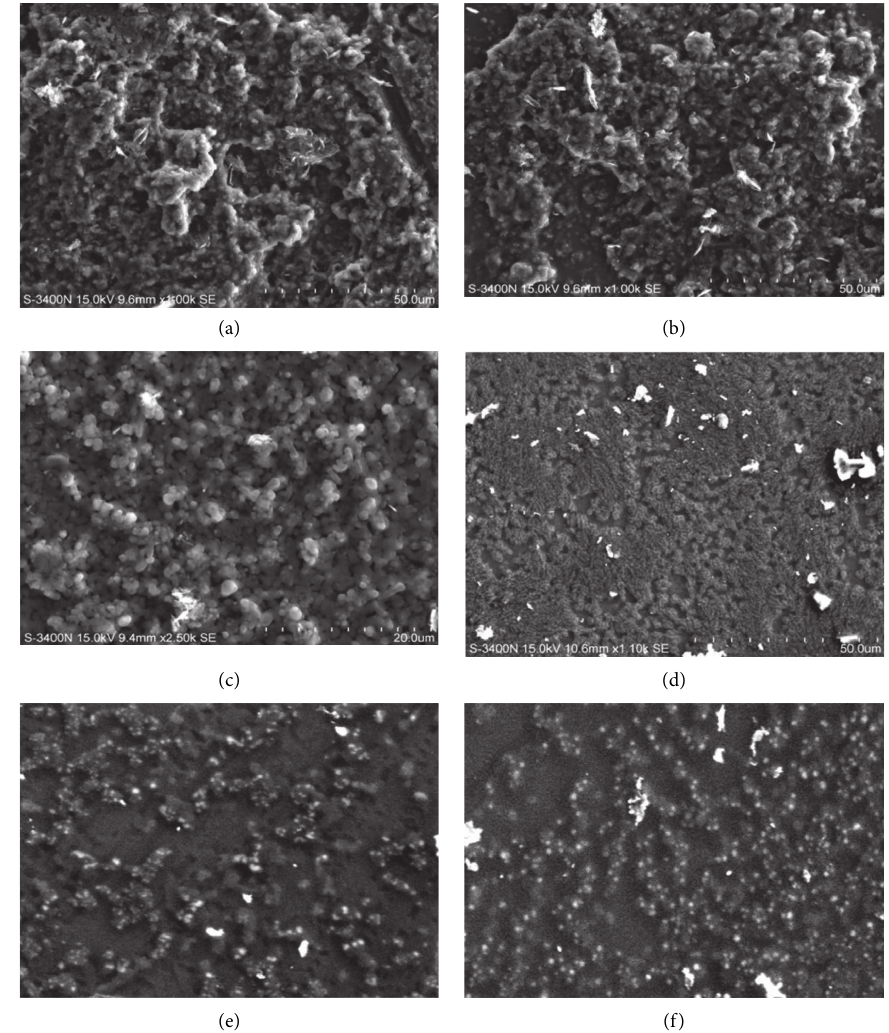
Figure 5: The effect of amylase on the preformed (24h) biofilm; the biofilm nature was disrupted and resulted in the disruption of microcolonies (a–c). The tightly bound biofilm of S. Typhi , Listeria sp., and B. cereus (d–f). (e) 9.5mm × 1.0K · SE and (f) 9.5 mm × 1.0K ·